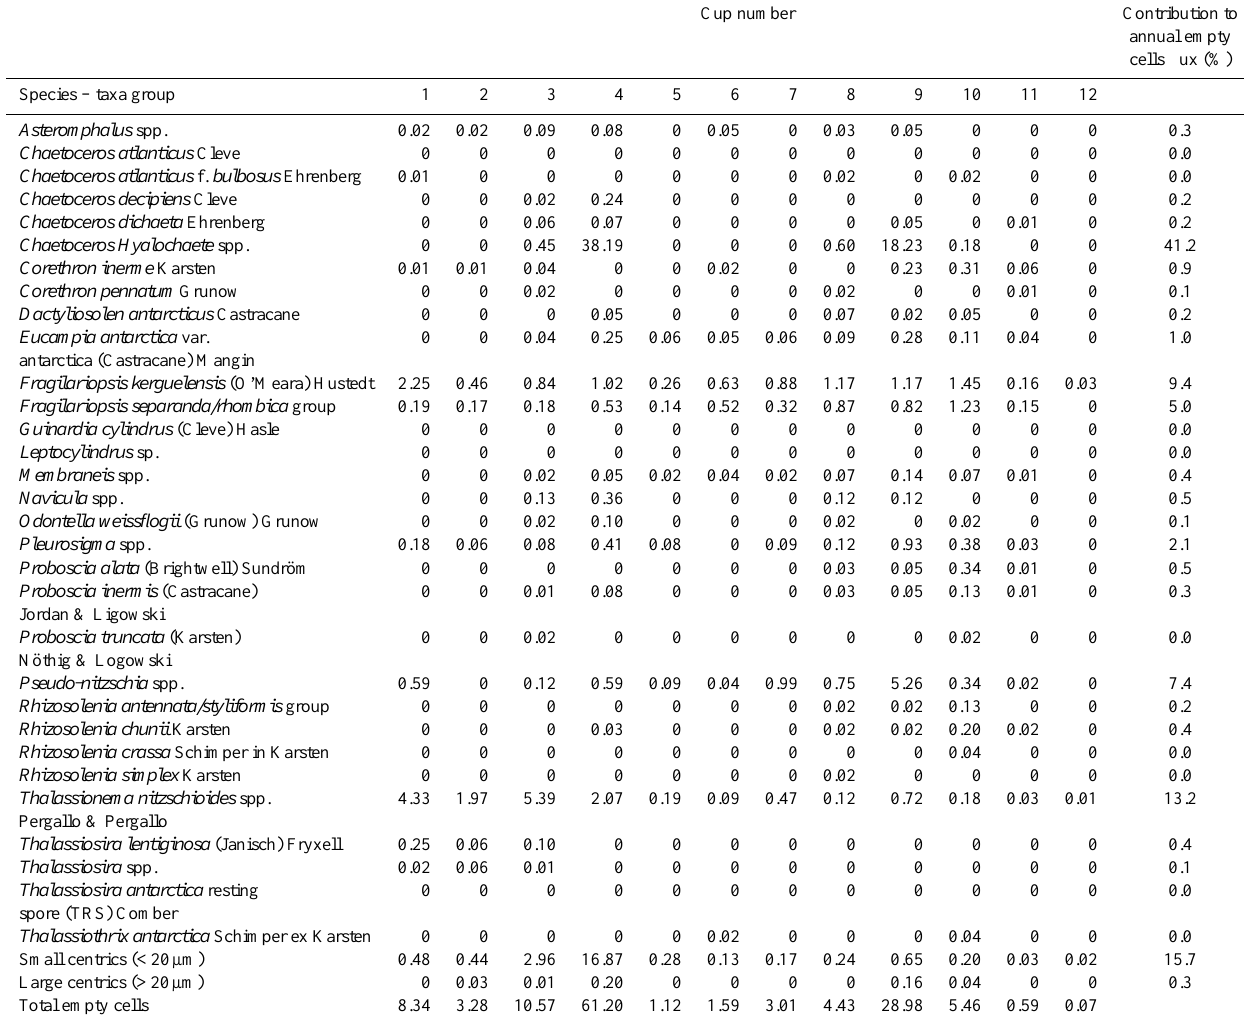
Cup number Contribution to